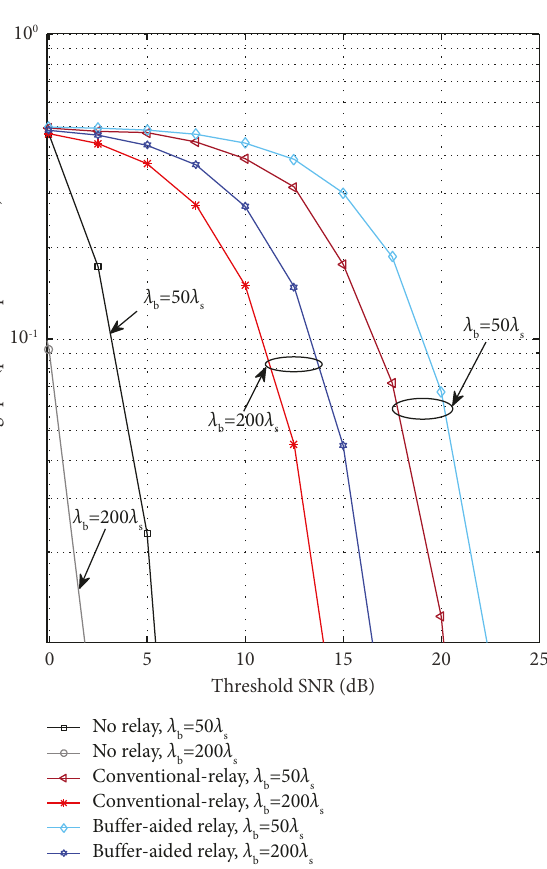
Figure 5: The impact of different relay densities on the relay- assisted mm-wave and the proposed